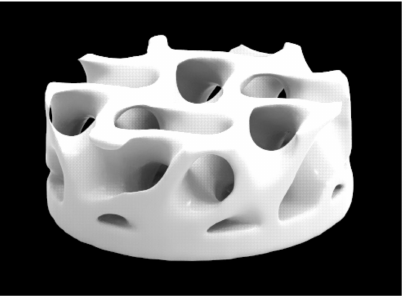
Figure 1. Isometric view of the scaffold STL designed in this